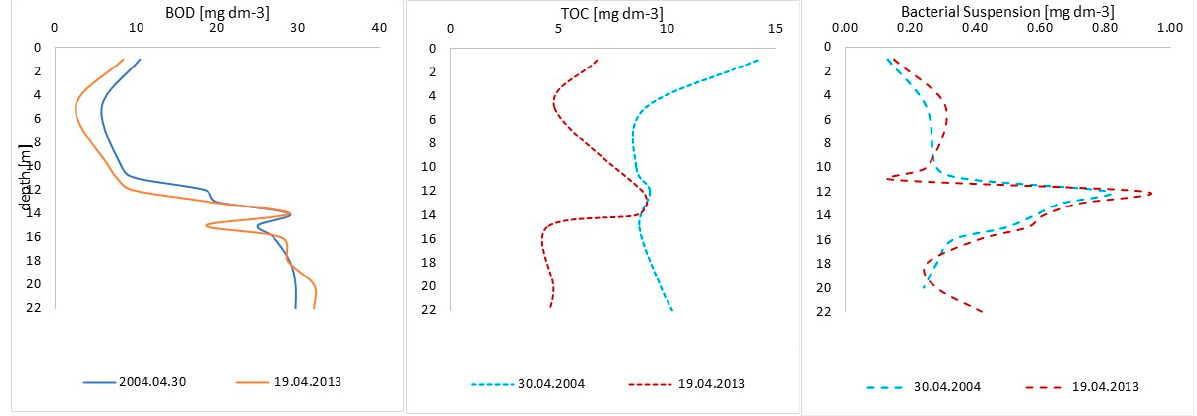
Figure 6. Vertical profiles showing changes in organic matter concentration defined as BOD 5 , TOC, and bacterial suspension.